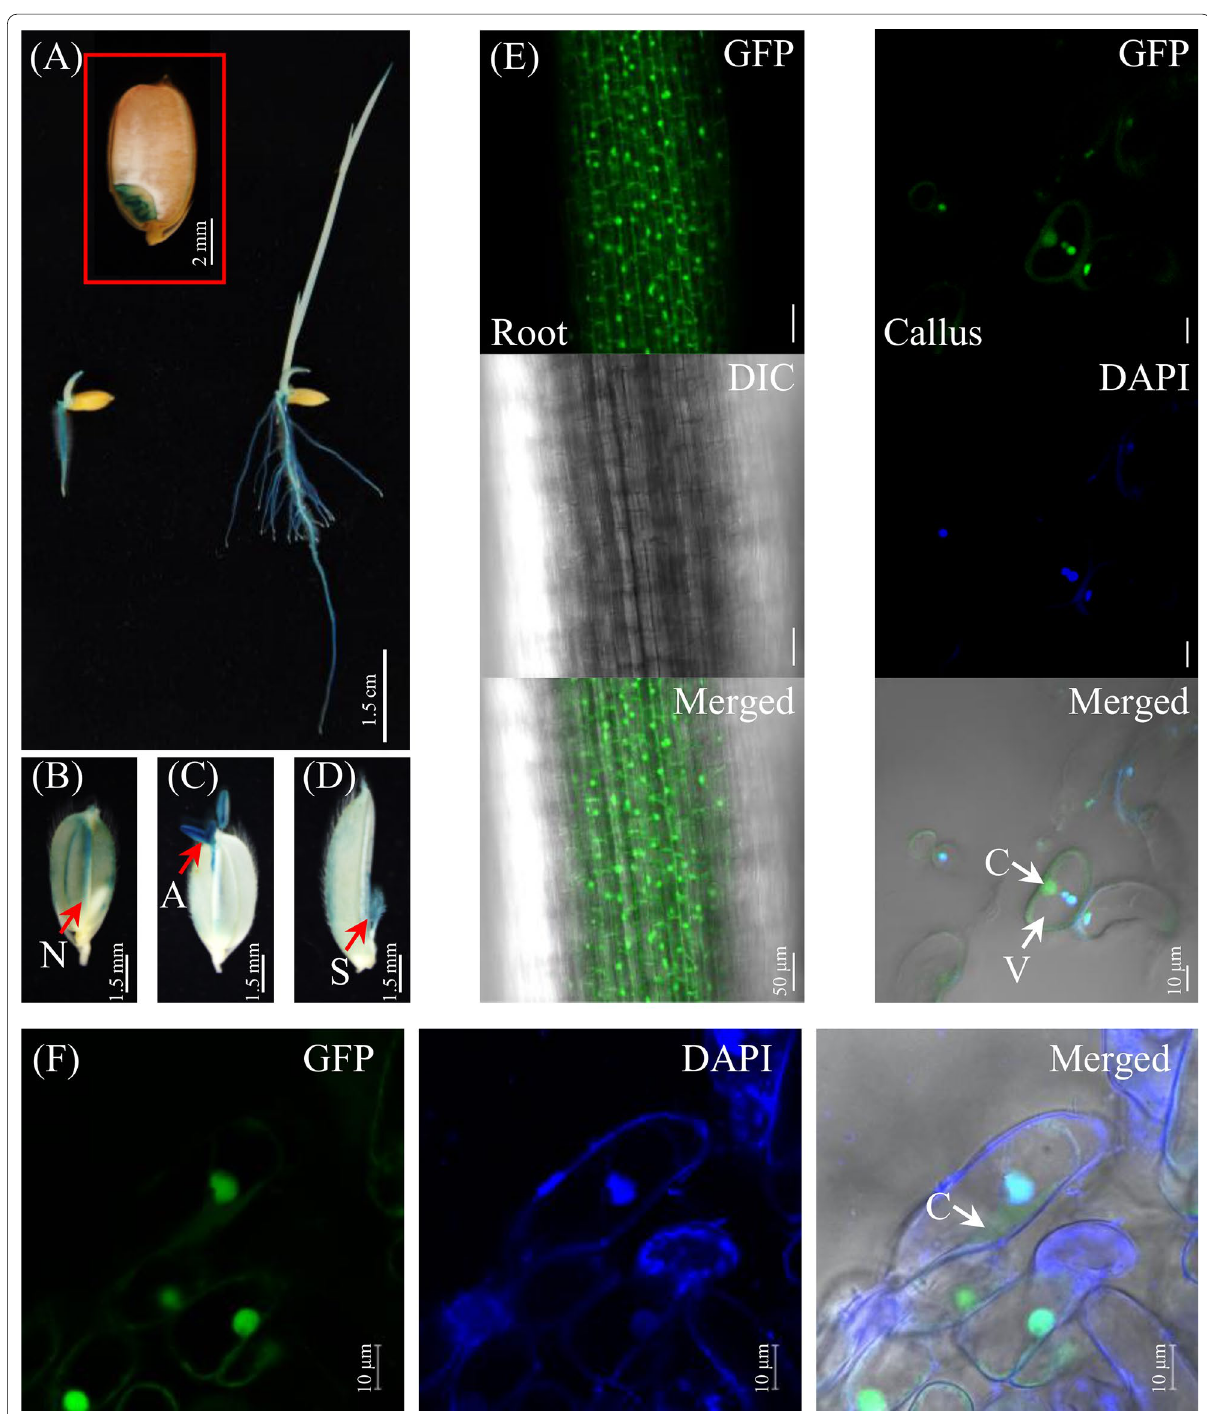
Fig. 2 The spatiotemporal expression of OsERF106MZ and the subcellular localization of OsERF106MZ‑GFP in stable rice transformants. a GUS staining of germinating seeds (insert) and post‑germination‑stage seedlings from an OsERF106MZp::GUS transformant. b – d GUS activity in developing flowers of an OsERF106MZp::GUS transformant. N, nerve; A, anther; S, stigma. e The presence of OsERF106MZ‑GFP in the root vasculature (left panels) and callus cells (right panels). f Subcellular localization of OsERF106MZ‑GFP in the NaCl‑treated callus cells. The calli induced from the husk‑removed seeds harboring 35Sp::OsERF106MZ-GFP were treated with 150 mM NaCl for 24 h and then subjected to GFP visualization by confocal microscopy. C, cytosol; V,